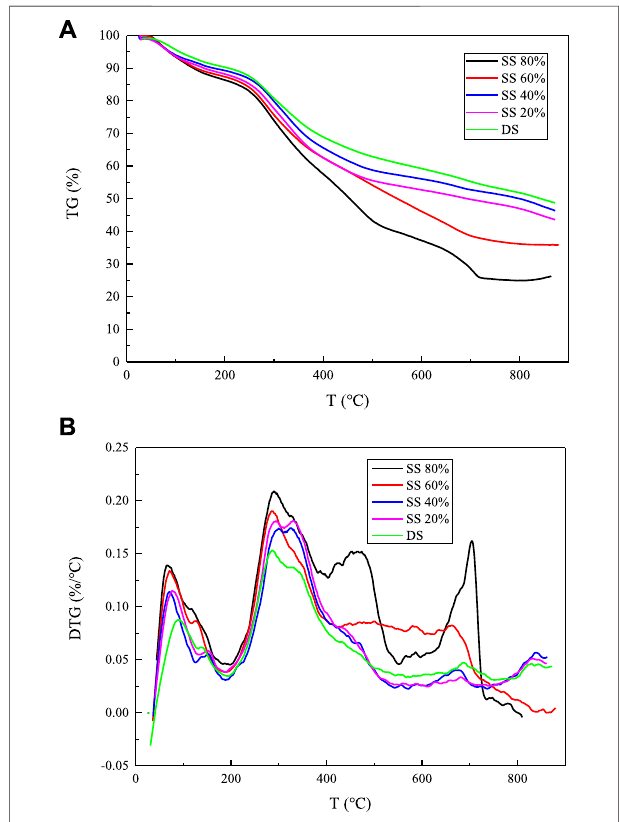
FIGURE 2 | Thermogravimetric analysis of sludge and steel slag with different mixing ratios: (A) TG curve and (B) DTG curve.